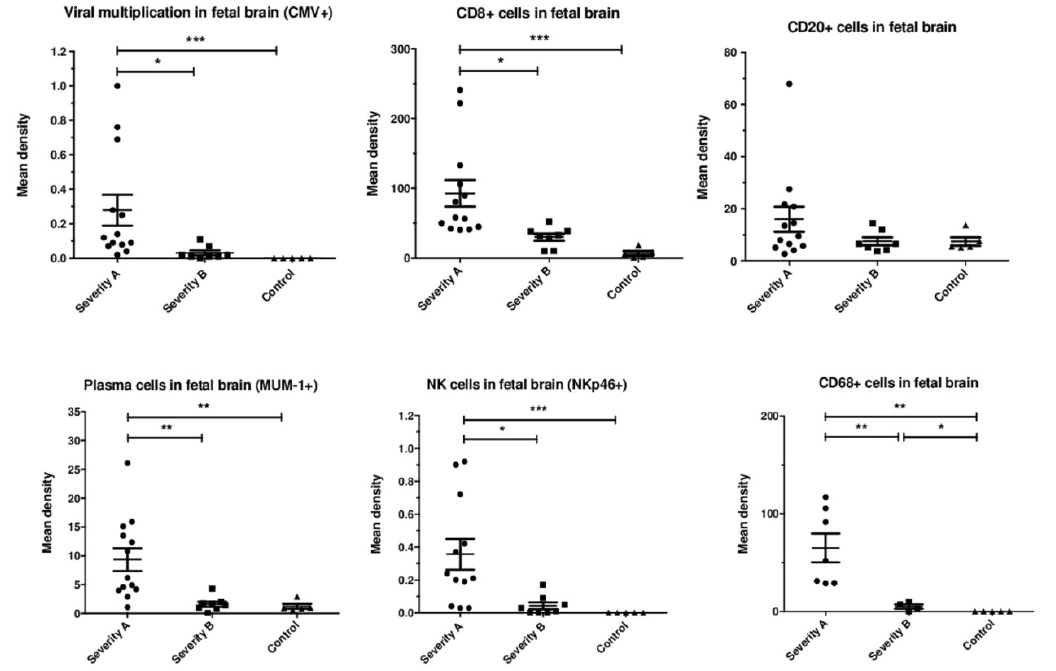
Figure 3. Mean immunostaining densities of HCMV-positive cells and immune cells according to the severity of the brain lesions: severe (group A, N = 13), moderate (group B, N = 8), and controls ( N = 5); * p < 0.05, ** p < 0.01, *** p < 0.001. Kruskal–Wallis test was used with Dunn’s Multiple Comparison’s